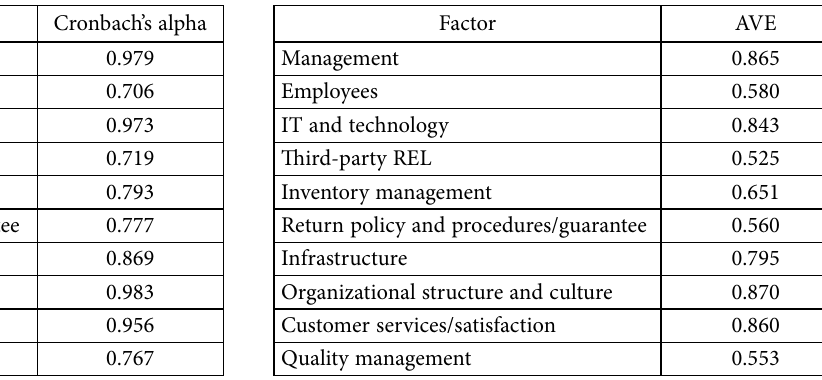
Table 6. Values of Cronbach’s alpha Table 7. Values of AVE